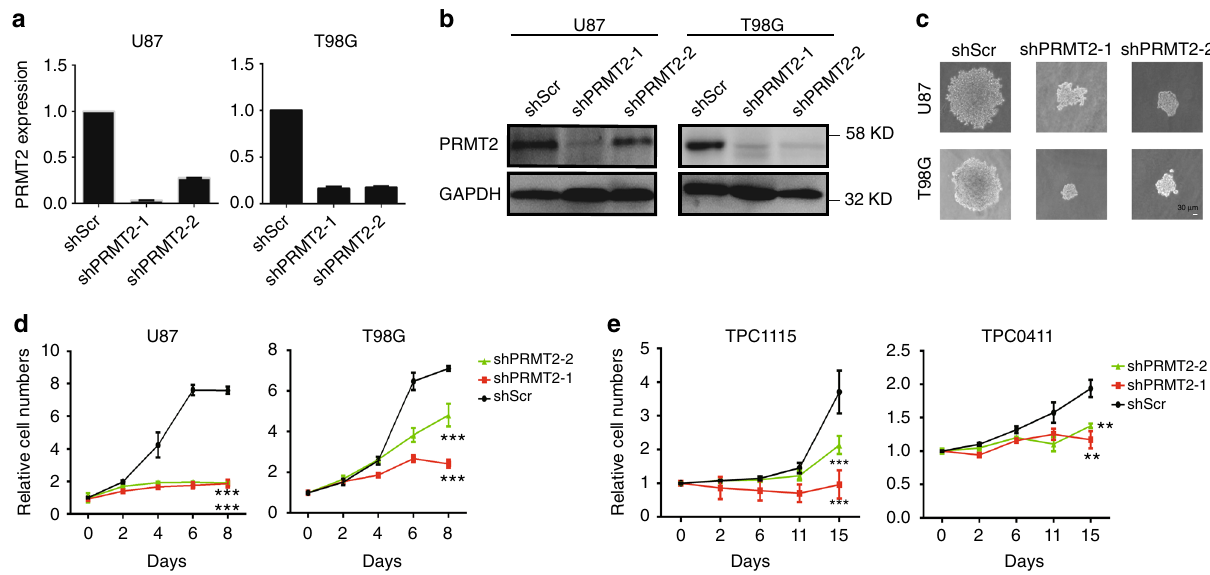
Fig. 2 PRMT2 is required for GBM cell anchorage-dependent and -independent growth. a , b PRMT2 expression levels in U87 and T98G cells transduced with two different shRNA constructs targeting PRMT2 (shPRMT2-1 and shPRMT2-2) or scramble shRNA (shScr) were determined by RT-qPCR ( a ) and WB analysis ( b ). GAPDH serves as a loading control. The error bars in a denote SD, n = 2. c Anchorage-independent growth of U87 and T98G cells transduced with shScr or shPRMT2 was measured by colony formation in soft agar. Representative colonies were photographed after 4 weeks. Scale bar, 30 µ m. d , e Cell growth curves of U87 and T98G cells ( d ), TPC1115 and TPC0411 cells ( e ) expressing the indicated shRNAs. MTS assay was employed at Error bars, ± SD, n =